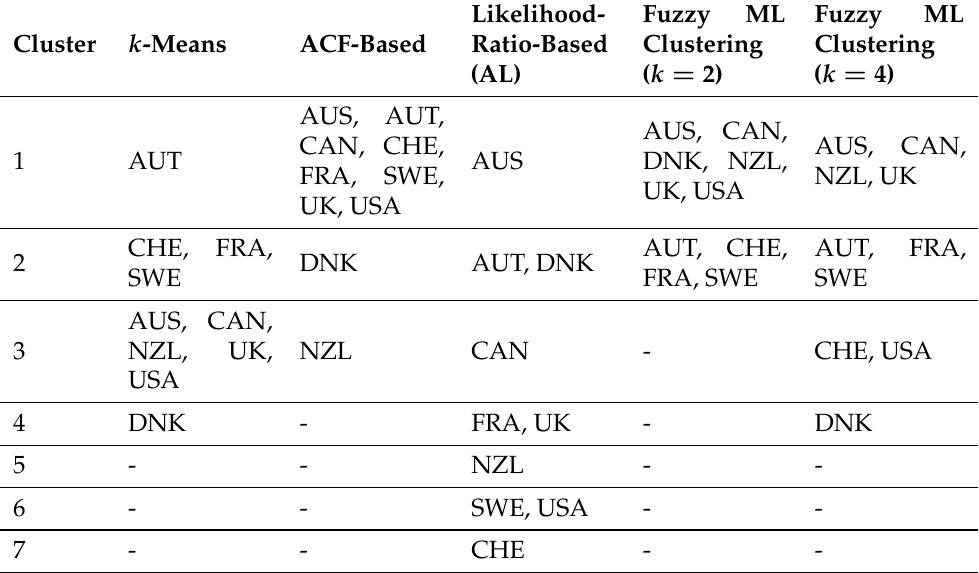
Table 1. Comparison of clustering results obtained by different algorithms for males aged 53 to 87 in 10 countries between 1948 and